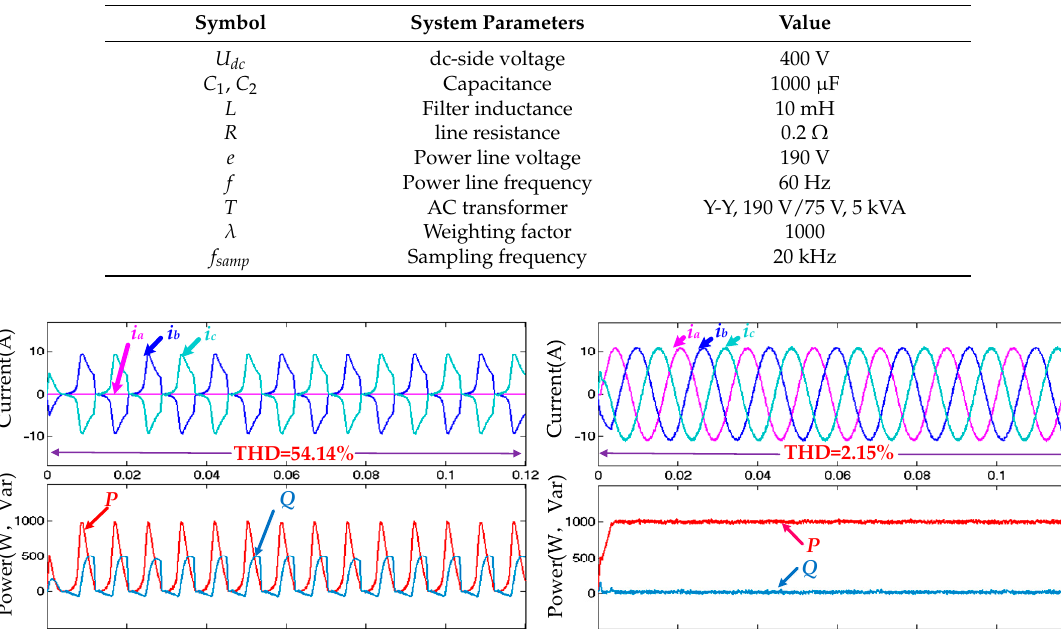
Table 2. System parameters of fault-tolerant BVSC.